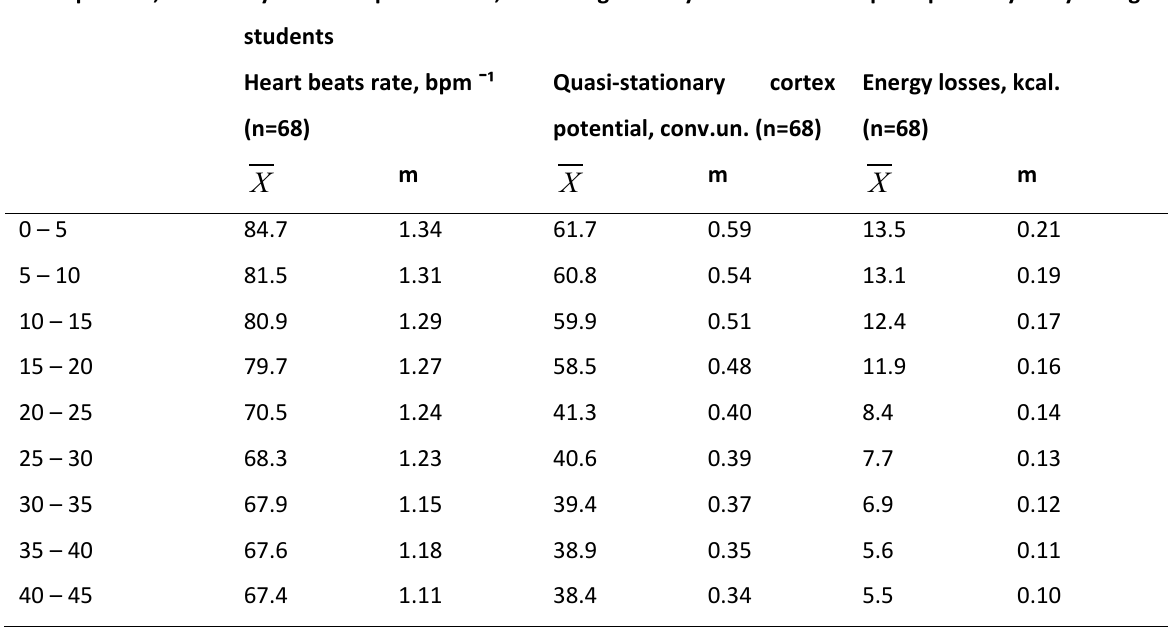
Table 1. Characteristics of heart beats rate, quasi-stationary cortex potential and energy losses of 1 st year girl students, registered during mastering multimedia manual’s material Time periods,